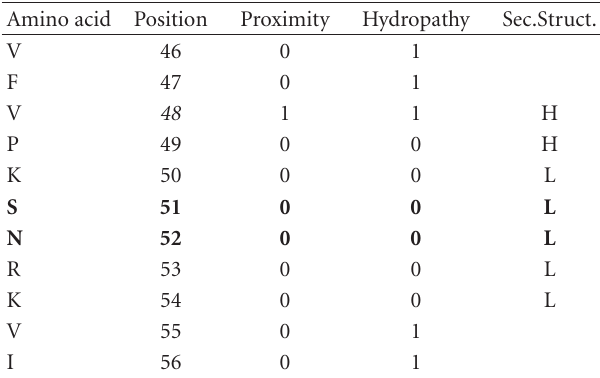
Table 2: Example of a center of bond enlargement. The columns show the amino acid one-letter code, the residues coordinates, the status of proximity with respect to the pattern chain in the complex, the status of hydropathy (1 hydrophobic, 0 hydrophilic) and the secondary structure (H = alpha chain; L = loop) of every amino acid around a center of bond. The center of bond is represented by the amino acids within the bold lines (i.e., S and N); the grey- highlighted rows are the results of the symmetrical enlargement due to hydropathy, while the amino acid reported in italic (V) are grouped because of its proximity to the opposite chain. Amino acid Position Proximity Hydropathy